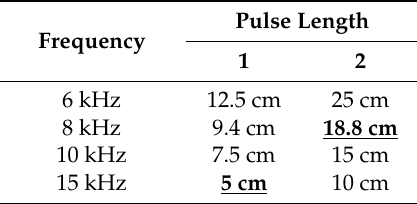
Table 2. Vertical resolution of the parametric sediment echo sound in dependence on frequency and pulse duration. Settings used in the case study area are underlined. The vertical resolution was calculated according to Wunderlich et al. [19]. The speed of sound in seawater was set to 1500 m/s. Pulse Length Frequency 1 2 6 kHz 12.5 cm 25 cm 8 kHz 9.4 cm 18.8 cm 10 kHz 7.5 cm 15 cm 15 kHz 5 cm 10 cm